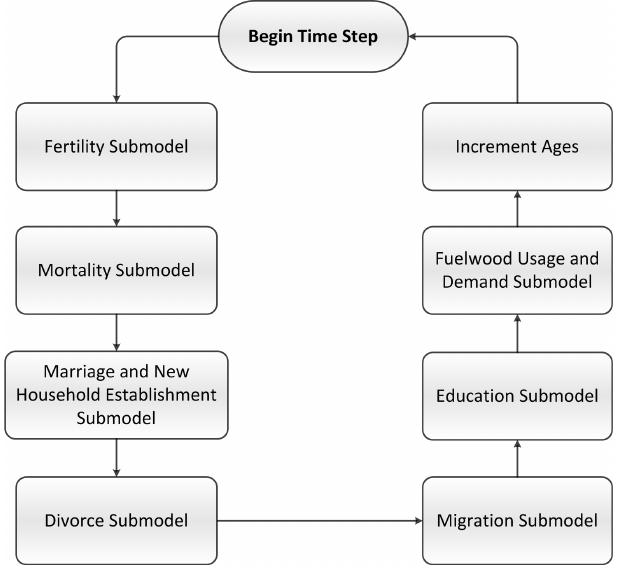
Fig. 2 . Process scheduling in the Chitwan agent-based